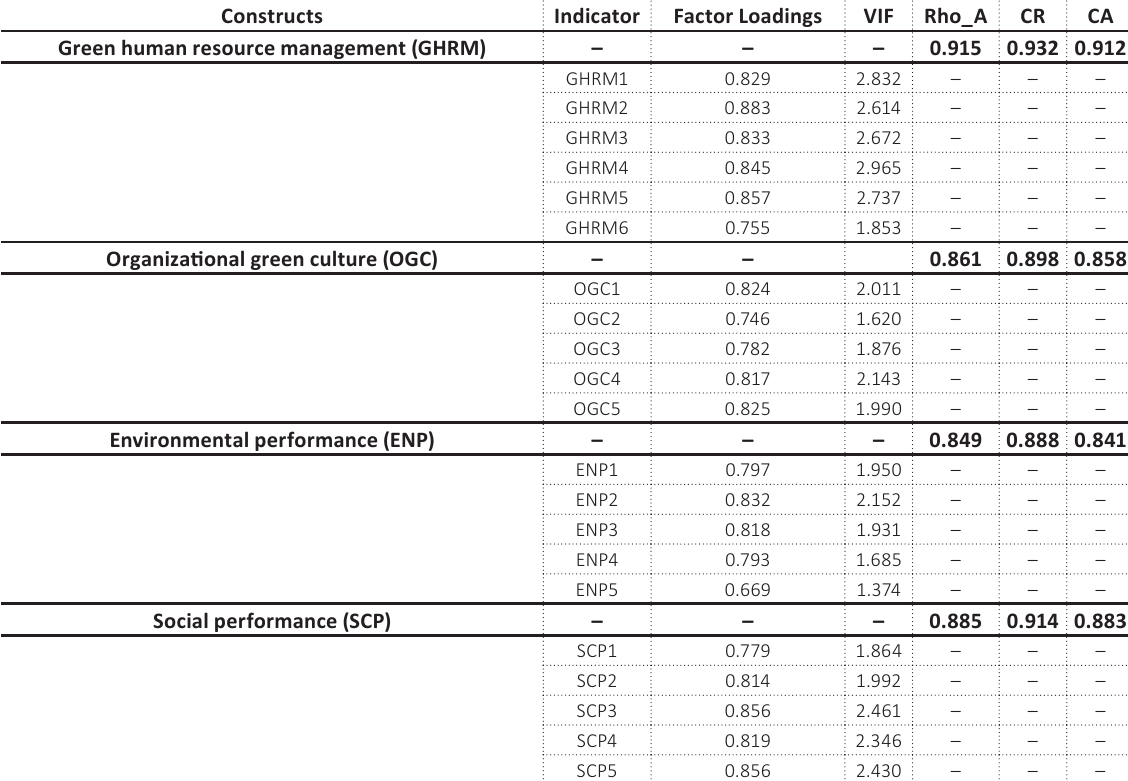
Table 2. Measurement